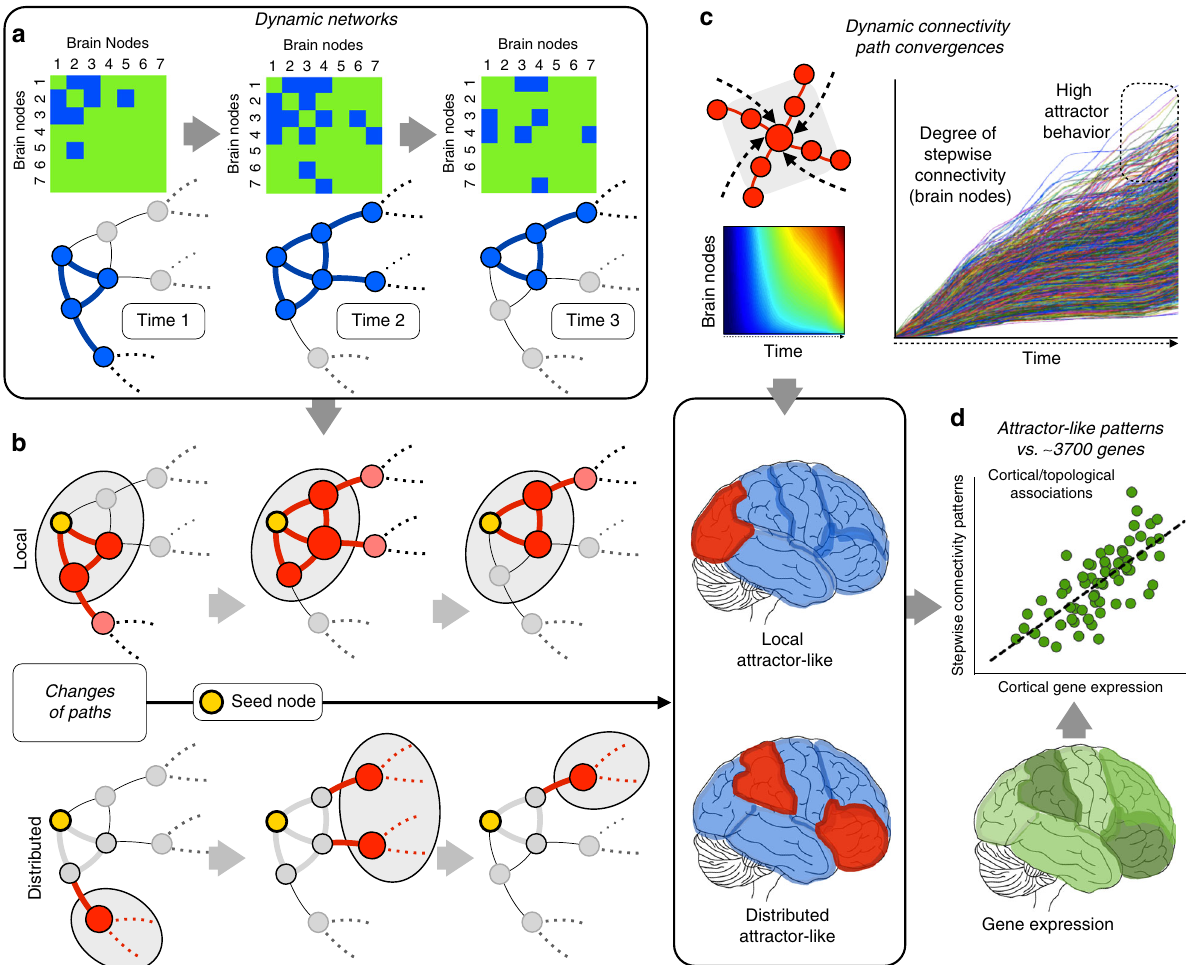
Fig. 1 a Dynamic connectivity was evaluated using network con fi gurations over windows of time through association matrices and graph changes. Three binary examples of time points are displayed for illustration purposes, although the real data are computed as weighted graphs. b To describe the local patterns of dynamic connectivity as well as distributed network changes outside local modules, we separately investigate the direct and indirect neighbors of all given investigated nodes in the entire cortex. As seen in the diagrams, this strategy enables the comparison of modular (or local) connectivity and distant connectivity. c SFC is used to investigate the functional streams that converge at speci fi c points of the cortex (network phase space). Top left: diagram of converging streams in a given node. Top right and top center: calculation of the recurrence of streams targeting voxels over time at the whole- brain level (lines graph and density graph). Bottom: Due to the segregation between local and distributed networks, we can independently investigate the local and distributed recurrence connectivity. The diagrams represent the cerebral cortex and red areas with high accumulative degree of recurrent streams hitting them over time. d Local and distributed recurrence connectivity maps are compared with neuro-related genes of the human transcriptome (theoretical example shown as the green cortical map) via spatial similarity using a linear regression approach